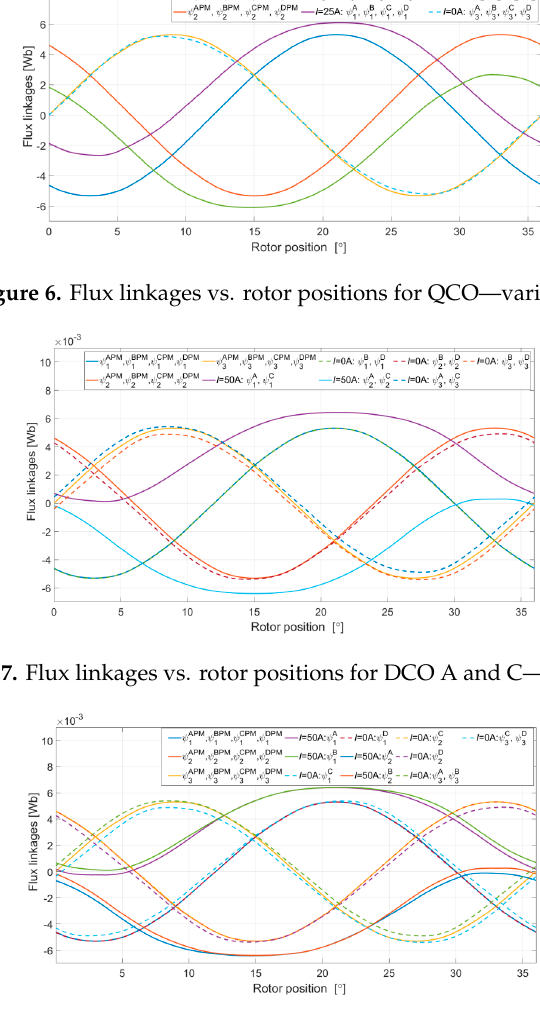
Figure 8. Flux linkages vs. rotor positions for DCO A and B—variant I.